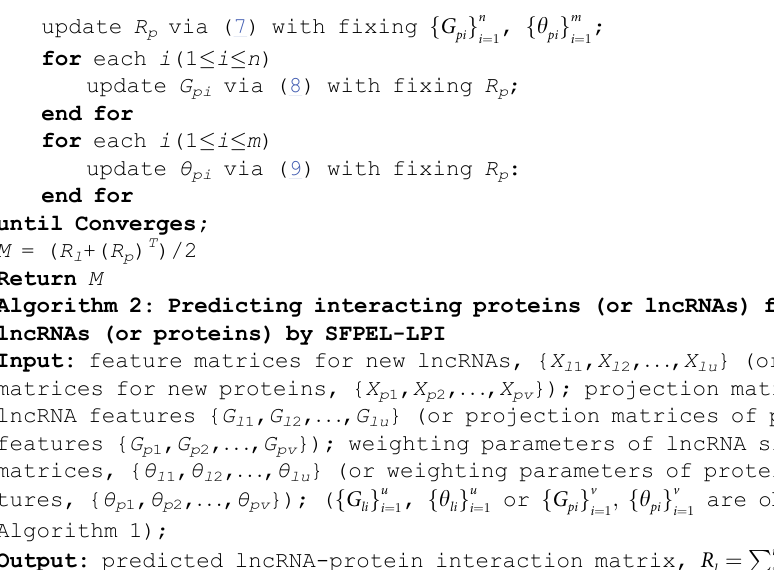
Algorithm 2 : Predicting interacting proteins (or lncRNAs) for